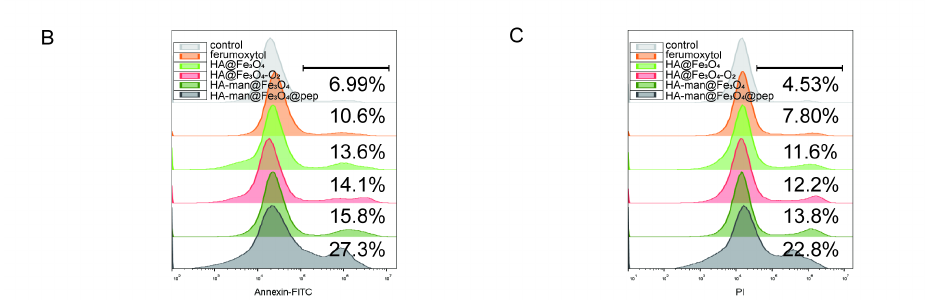
Figure 5. TC1 cell apoptosis in vitro mediated by RAW 264.7 and materials. ( A ) Fluorescence images of TC1 cells following coculturing with RAW 264.7 cells; ( B , C ) flow cytometry analysis of TC1 cells following coculturing with RAW 264.7 cells. Representative results are displayed.